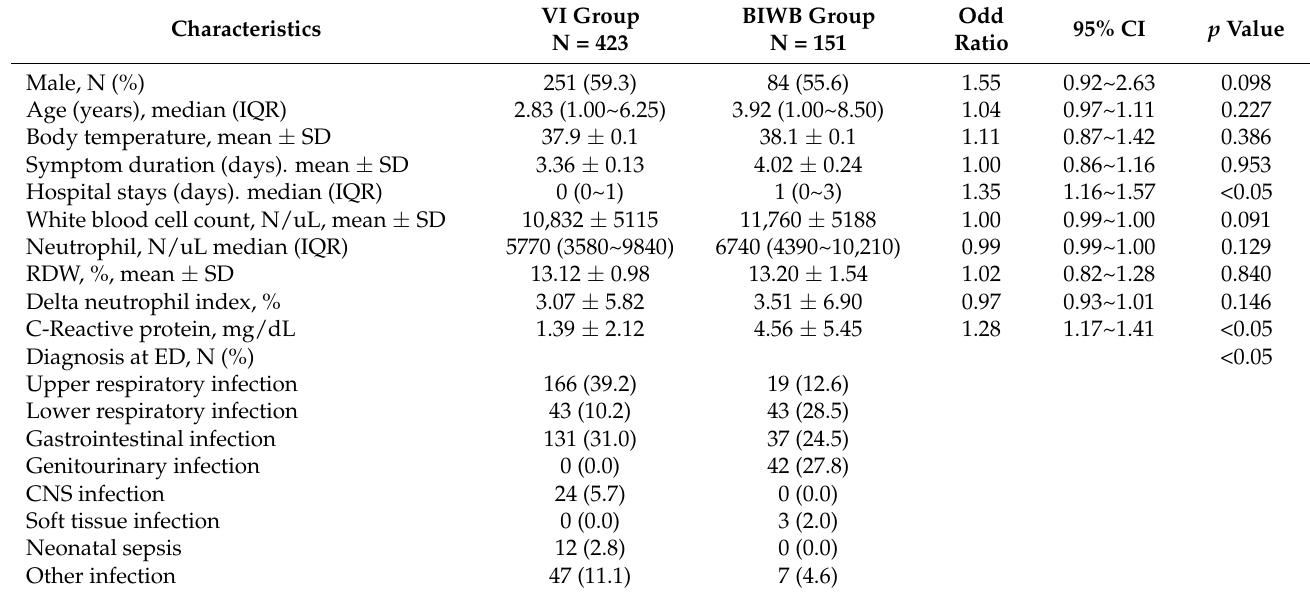
Table 1. Baseline demographic